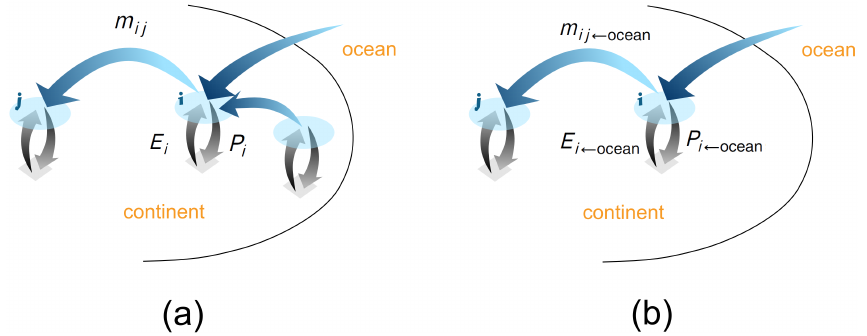
Fig. B1: Scheme explaining the removal of CMR. Originally, the precipitation in the grid cell i ( P i ) is composed by oceanic and continental moisture. The total incoming moisture is evaporated in i ( E i ) and some part of it contributes to precipitation in the grid cell j ( m ij ) (a) . If we forbid the re-evaporation of continental precipitation, only the precipitation in i that has oceanic origin ( P i ← ocean ) is evaporated in i ( E i ← ocean ) and can contribute to precipitation in j ( m ij ← ocean ) . By doing so, we remove cascading recycling of continental moisture from the network (b) .